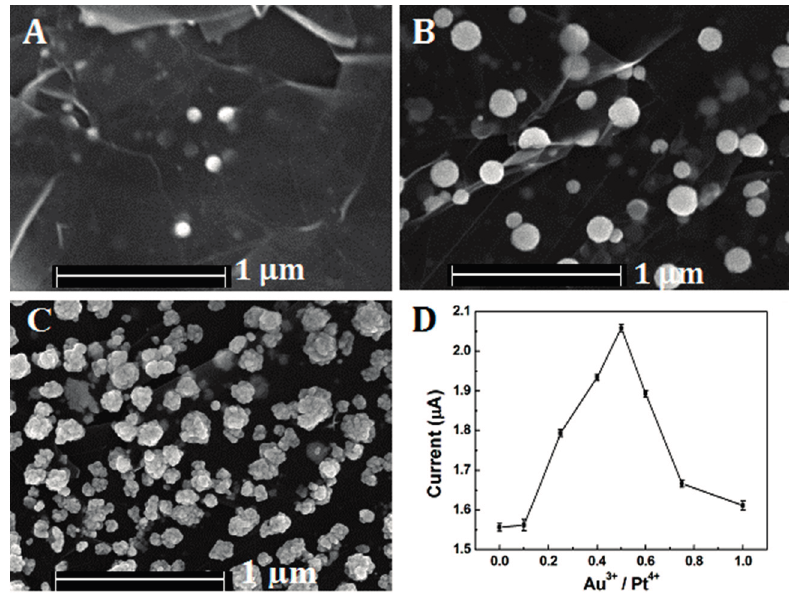
Figure 2. FESEM images of Pt-Au/rGSs hybrid films with different compositional ratios: Au 3+ /Pt 4+ = ( A ) 0:1, ( B ) 1:2 and ( C ) 1:0; ( D ) plots of the peak current for the Pt-Au/rGSs/GCE in the presence of 0.1 mM H 2 O 2 vs. different Au 3+ , Pt 4+ compositional